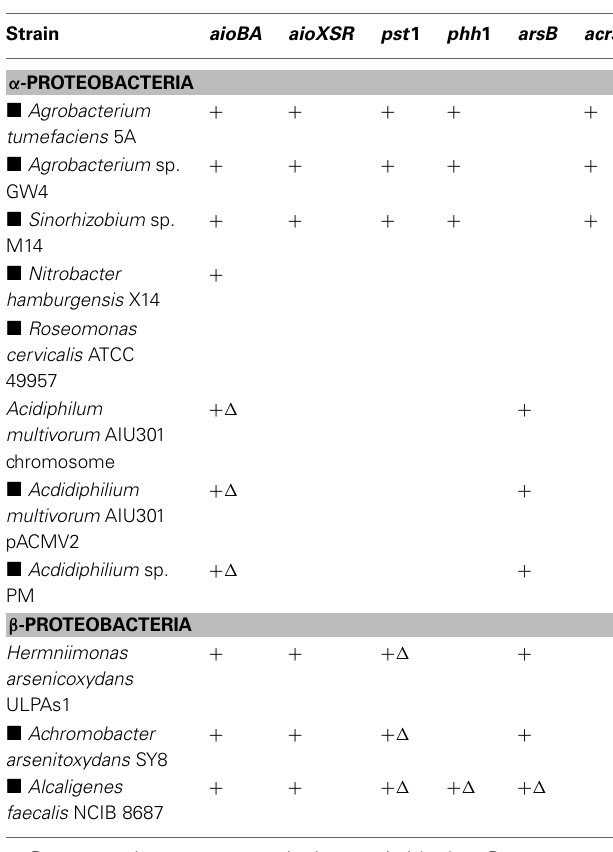
FIGURE 4 | Phylogenetic trees of PhnC1 and 16S rDNA sequences. Bold and ∗ symbol represent proteins from the strains of the arsenic islands while the others are not. Putative horizontal gene